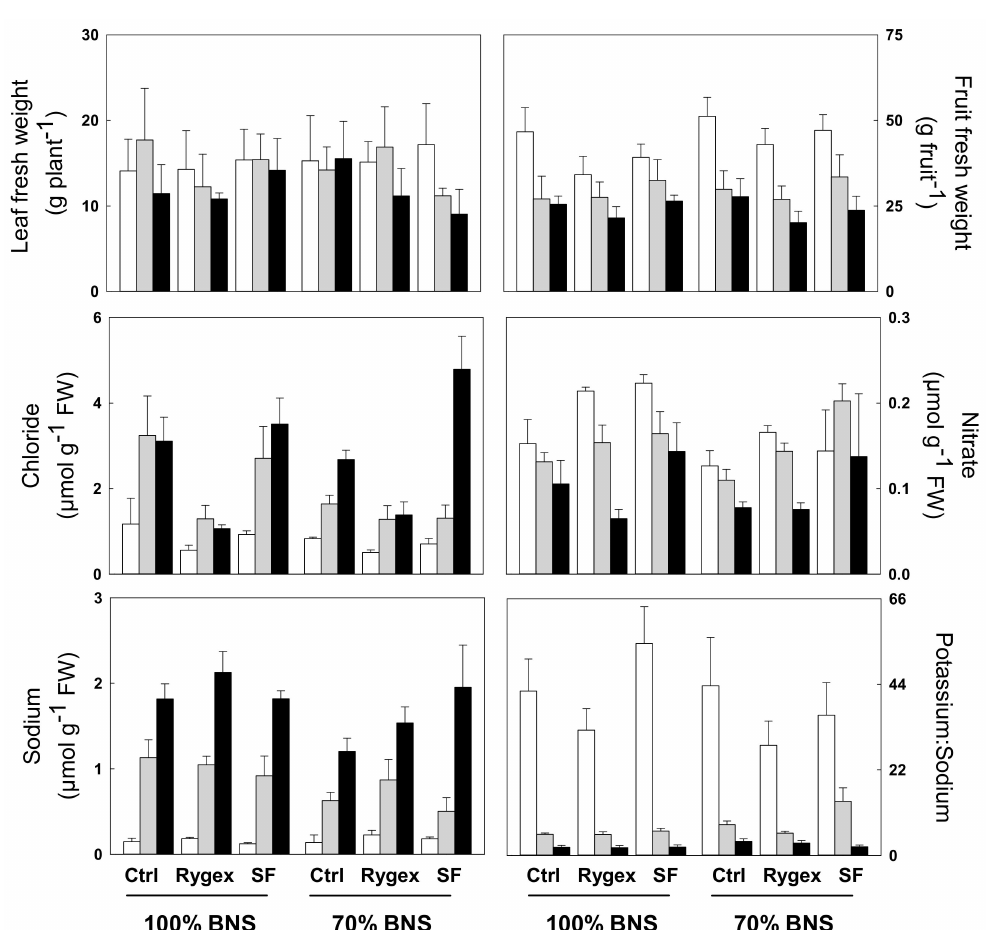
Figure 1. Leaf fresh weight, fruit fresh weight, leaf content of chloride, nitrate, sodium ), and the potassium to sodium ratio. MicroTom plants were harvested at 90 days after sowing (DAS) after being fertigated since 35 DAS with a 100% or 70% basic nutrient solution (BNS), in combination with three salinity levels of 0 (white bars), 42.5 (grey bars), and 85 (black bars) mM NaCl and two different commercial two commercial Ascophyllum nodosum extracts, Rygex at 2.5 mL L − 1 and Superfifty (SF) at 2.0 mL L − 1 . Control (Ctrl) was without biostimulant. The values are mean ± S.D. ( n = 5 for morphological traits and n =3 for the ion measurements). Significance of the main factors (nutrient solution, biostimulant and salinity) and their interactions is shown in Tables 1 and